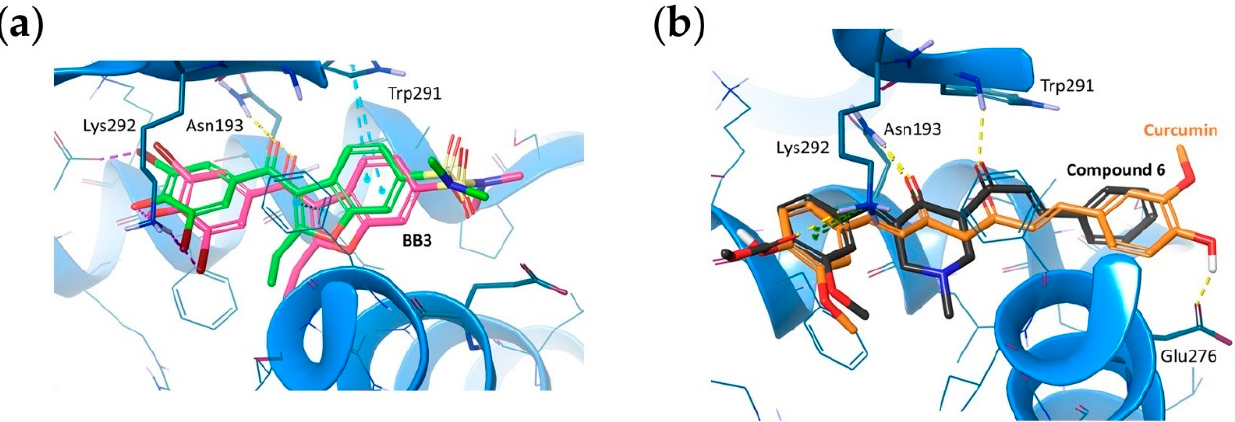
Figure 8. ( a ) Spatial orientation of BB3 within the allosteric site of PtP1B in the original crystal structure (PDB ID: 1T48; green ligand) and docked to the obtained, optimized model (pink ligand). RMSD obtained for BB3 redocking: 1.66 Å. CBR1 backbone displayed as blue ribbon. Amino acid residues engaged in ligand binding throughout H-bonds (dotted yellow lines), π -interactions (dotted blue lines), and halogen bonds (dotted purple lines) are displayed as sticks. ( b ) The predicted binding mode comparison of compound 6 (black) and curcumin (orange) within the allosteric site of PTP1B. Amino acid residues within 5 Å displayed as thin, blue sticks; amino acid residues engaged in ligand binding throughout H-bonds (dotted yellow lines) and π -cation interaction (dotted green lines) displayed as bold, blue sticks.